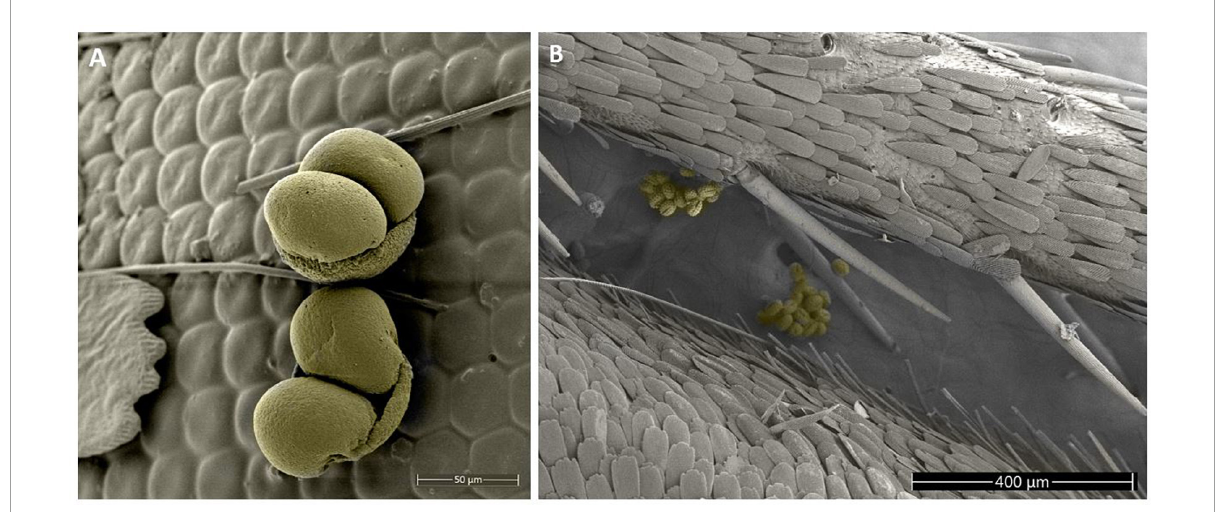
FIGURE1 Scanning electron microscope images of pollen grains on the legs and eyes of a skipper ( Hesperopsis libya , Hesperiidae) from the entomological collections of the University of Nevada Reno Museum of Natural History (UNRMNH). (A) Pinaceae pollen grains adhered to the butterfly’s eye. (B) Asteraceae pollen grains on the butterfly